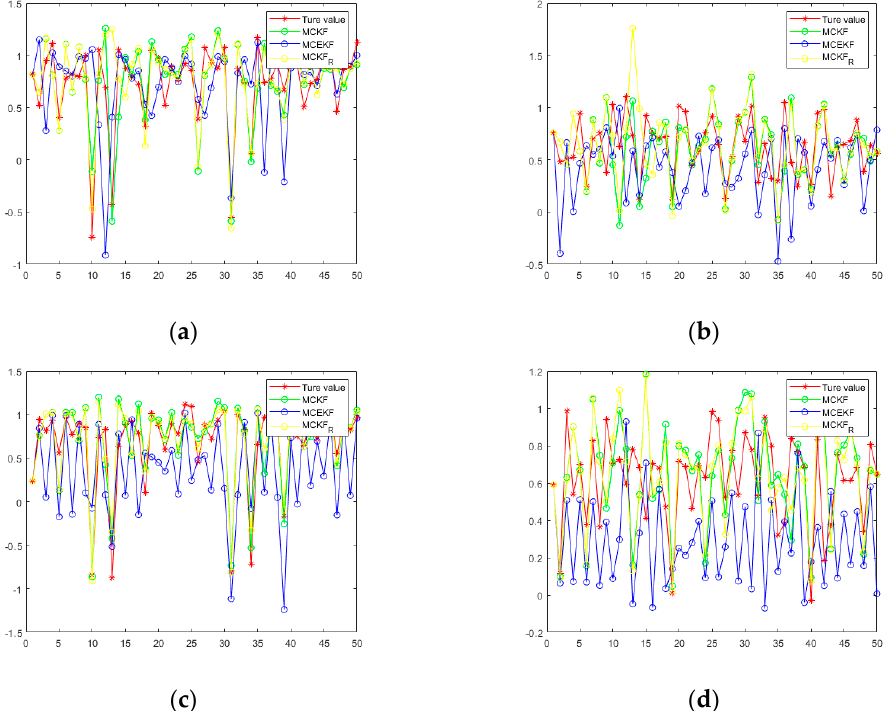
-6 10 σ= ε=10 ， in case 2.